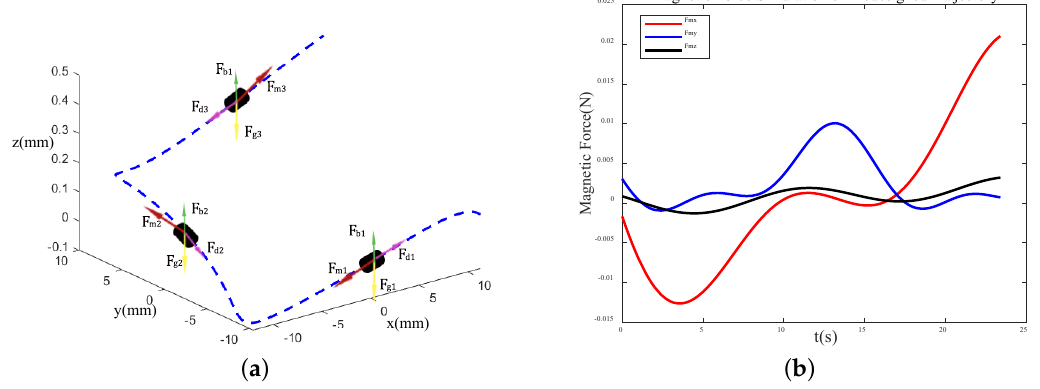
Figure 6. Magnetic force simulation of each point when the milli/microrobot moves along the planned spatial curve trajectory. ( a ) Schematic diagram of force decomposition of magnetic carrier in motion along a predetermined trajectory. ( b ) Schematic diagram of changes in the magnetic force component during the magnetic carrier’s completion of the predetermined